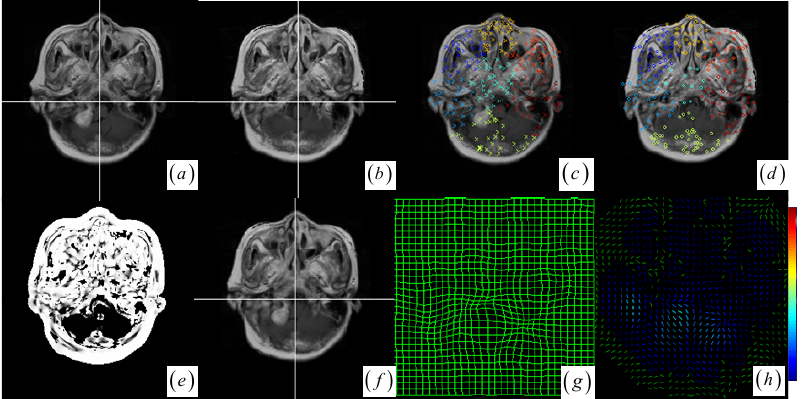
Figure 6. (a)–(b) The pre- and post-operative brain tumor images. (c)–(d) Significant keypoints selected from the different clusters. (e) JSM between the two images. (f) Fused image using check pattern after registration. (g) Warped mesh after registration. (h) Displacement vector